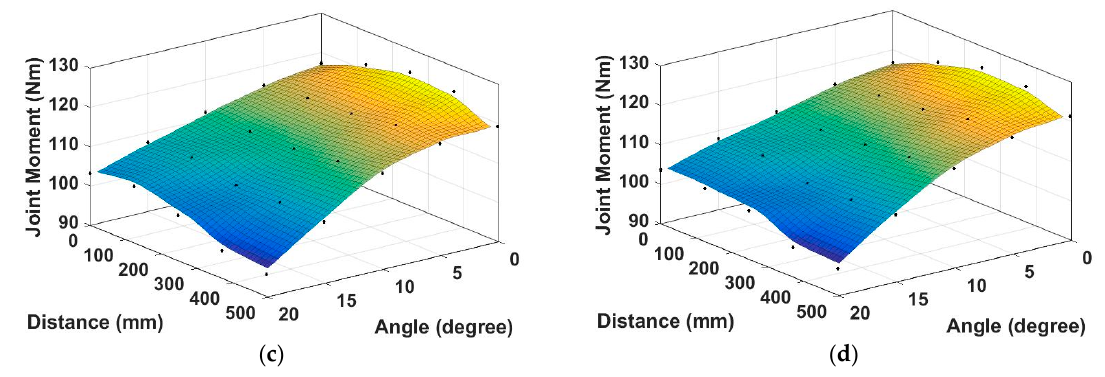
Figure 11. Simulated maximum moments of hip and knee joints for synthesized motions: ( a ) left hip moments and ( b ) right hip moments. ( c ) left knee moments and ( d ) right knee moments.